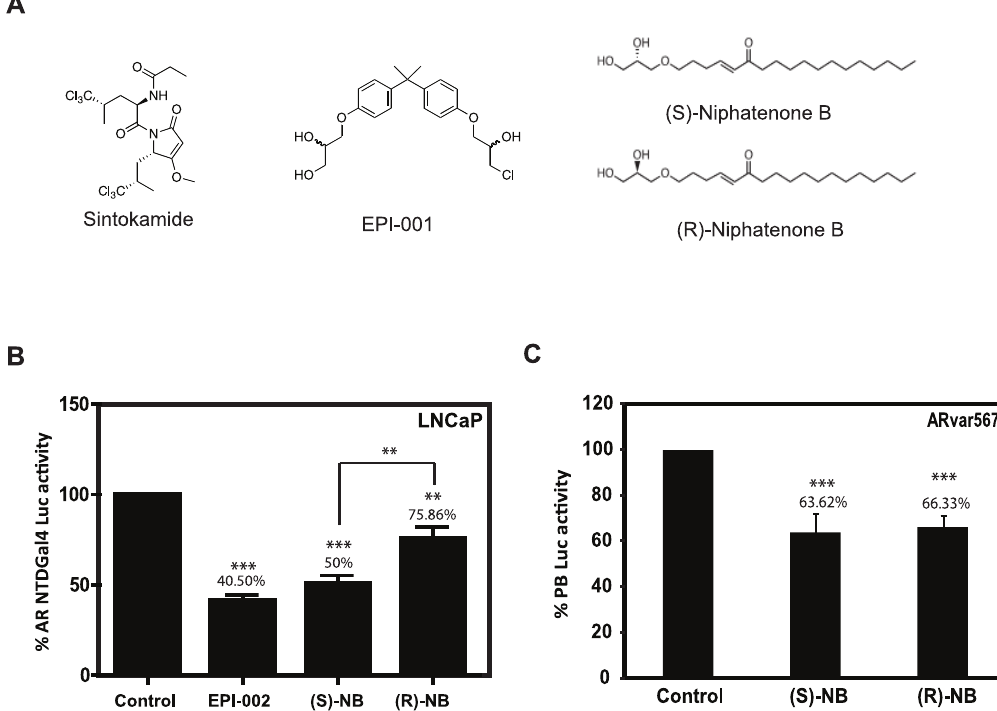
Figure 1. Niphatenone B enantiomers block transactivation of AR NTD. (A) Chemical structures of sintokamide, EPI-001, and niphatenone B enantiomers. (B) Transactivation assay of the AR NTD performed in LNCaP cells that were co-transfected with Gal4UAS-TATA-luciferase and AR-(1- 558)-Gal4 DBD prior pre-treatment for 1 hour with 25 m M EPI-002, 7.0 m M niphatenones or DMSO vehicle control. Transactivation of AR NTD was induced by incubation with IL-6 (50 ng/ml) for 24 hours. Luciferase activity was normalized to protein concentration. (C) Niphatenones inhibit the constitutively active AR V567es splice variant. Cos-1 cells co-transfected with PB-luciferase and an expression vector for ARvar567 were treated with each niphatenone B (1 m M) or DMSO vehicle control. After 24 hours of exposure, cells were harvested and luciferase activities were normalized to protein concentrations of the samples. Data represent the mean 6 SEM of n=3 separate experiments with triplicate wells. Student’s t test: ** P , 0.01; *** P , 0.001.